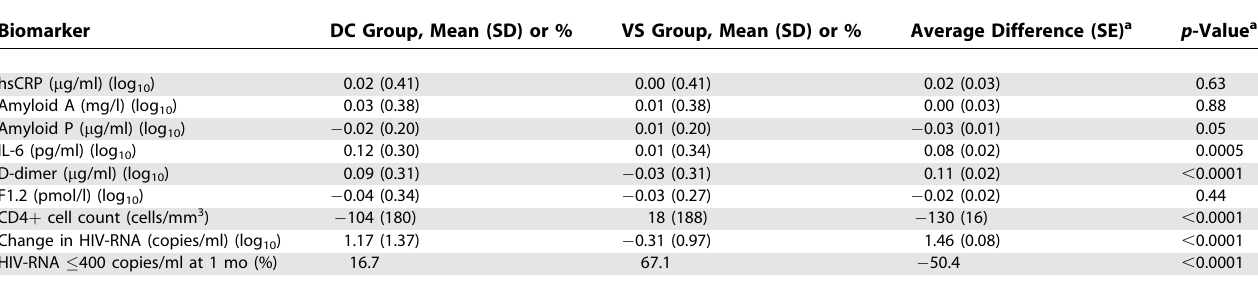
Table 7. Biomarker, CD4 þ Cell Count Change, and HIV-RNA Level Change 1 mo after Randomization Biomarker DC Group, Mean (SD) or % VS Group, Mean (SD) or % Average Difference (SE) a p -Value a